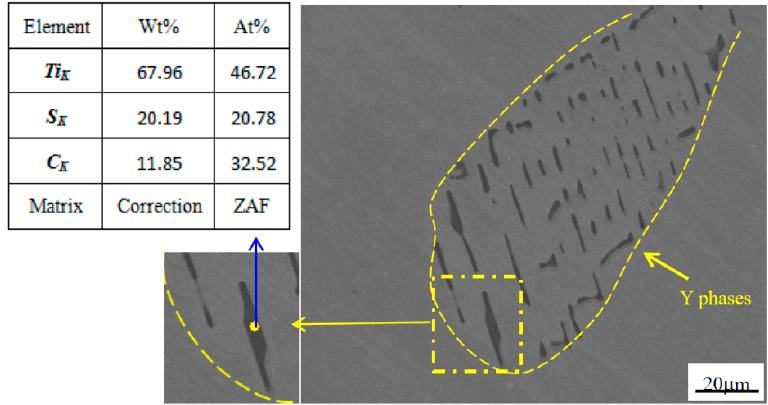
Figure 4. SEM image and EDS analysis of Y phase in AISI 321 after homogenizing annealing at 1290 °C for 24 h.